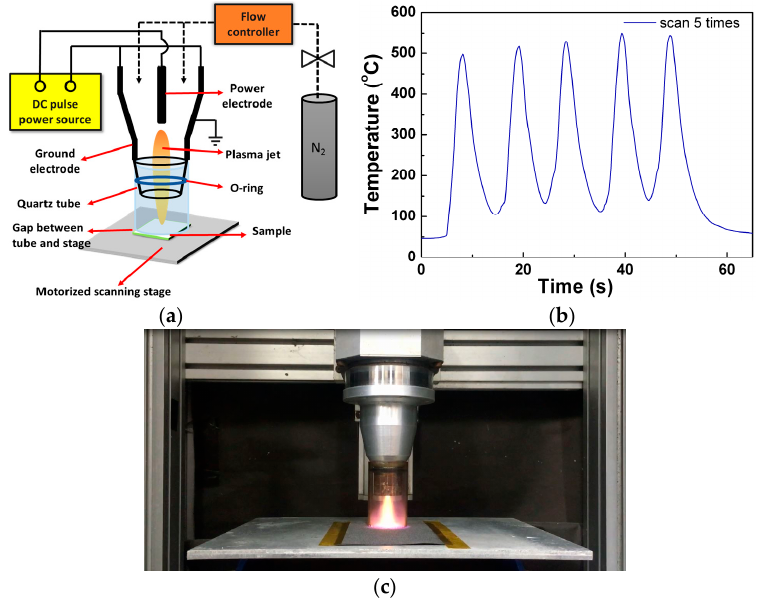
Figure 1. ( a ) DC-pulse APPJ setup with a motorized scanning stage; ( b ) Temperature evolution of the substrate with five scans; ( c ) Image of scan-mode nitrogen APPJ during